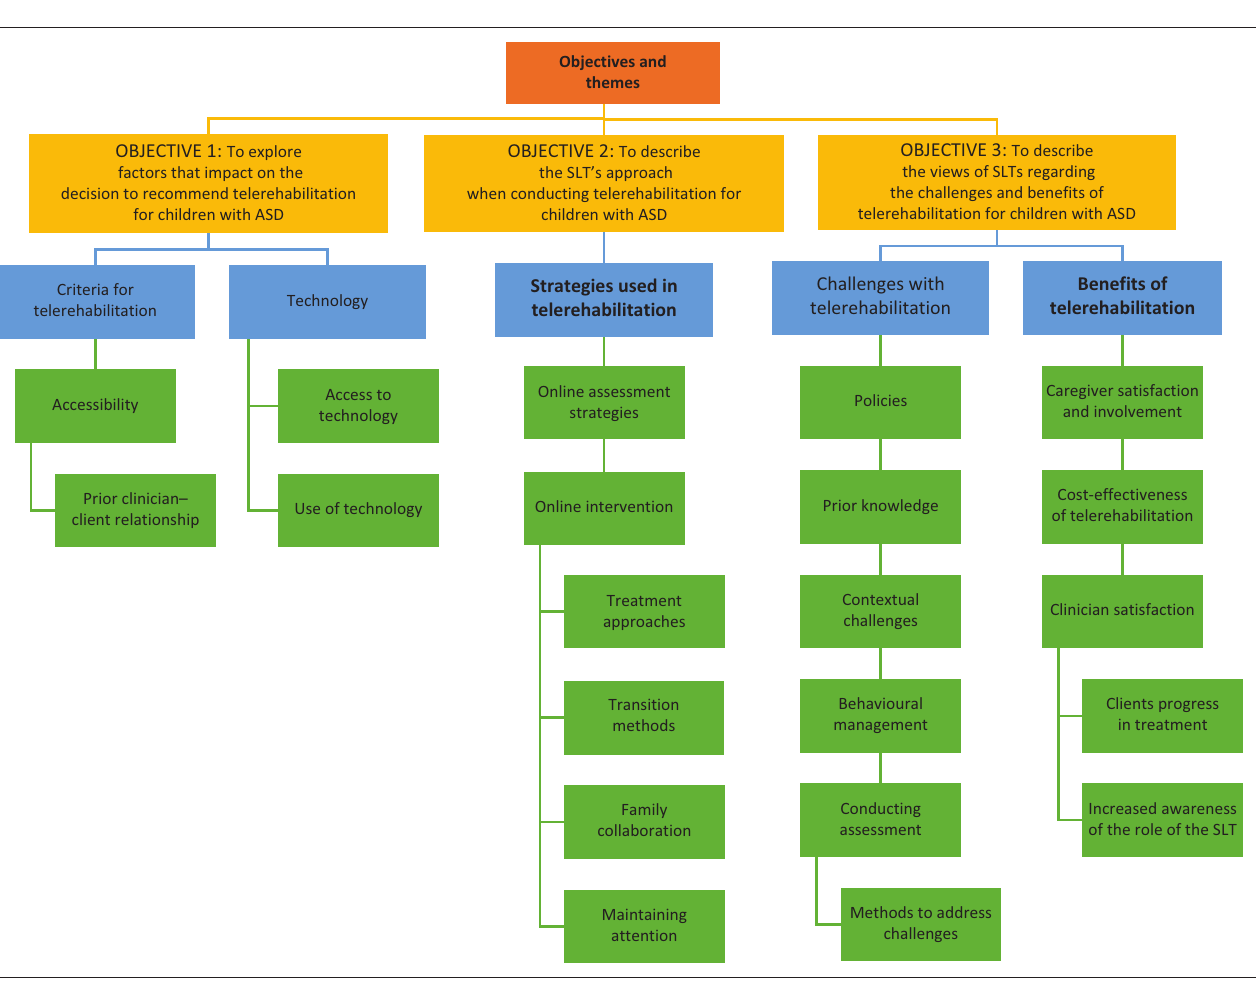
FIGURE 1: Overview of themes and subthemes that constitute the results of the